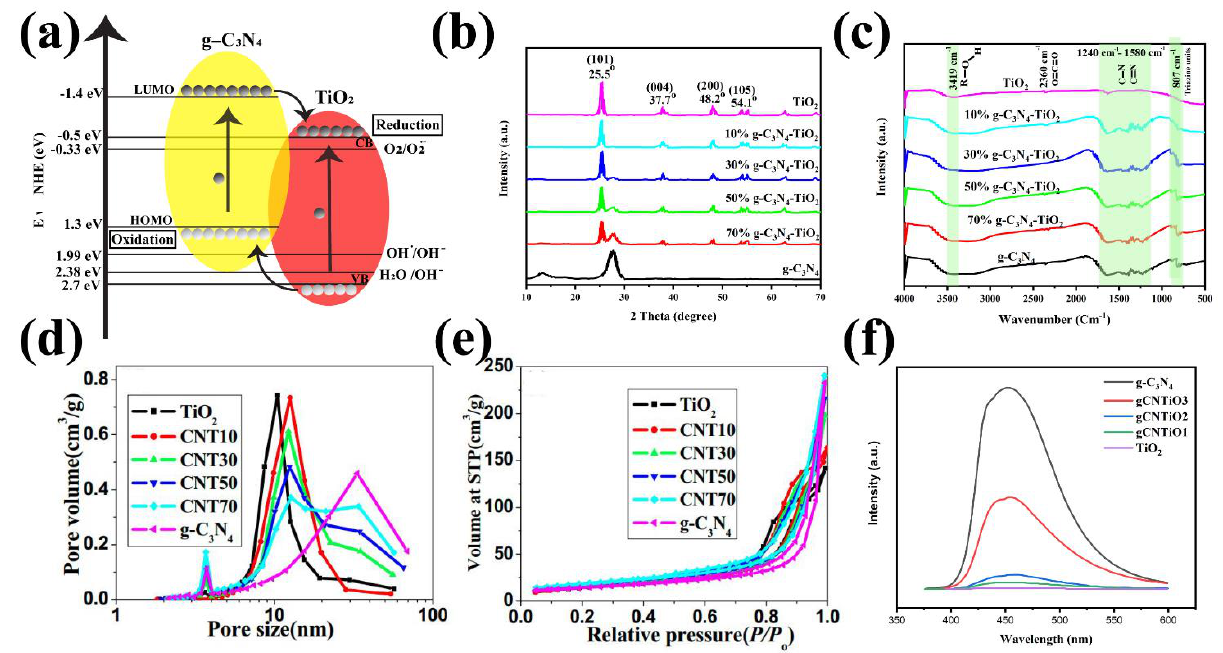
Figure 10. ( a ) Proposed mechanism for charge transfer of type II of the g-C 3 N 4 -TiO 2 heterojunction interface under visible light irradiation; ( b ) XRD patterns; ( c ) FT-IR spectra of the g-C 3 N 4 -TiO 2 heterojunction; ( d ) the pore size distribution curves; ( e ) UV-vis spectra of the prepared TiO 2 , g-C 3 N 4 , and TiO 2 - g-C 3 N 4 composites, Copyright © 2022 Elsevier [120]; ( f ) PL emission spectrum of TiO 2 , g-C 3 N 4 -TiO 2 , and g-C 3 N 4 products, Copyright 2019 © American Chemical Society [122].